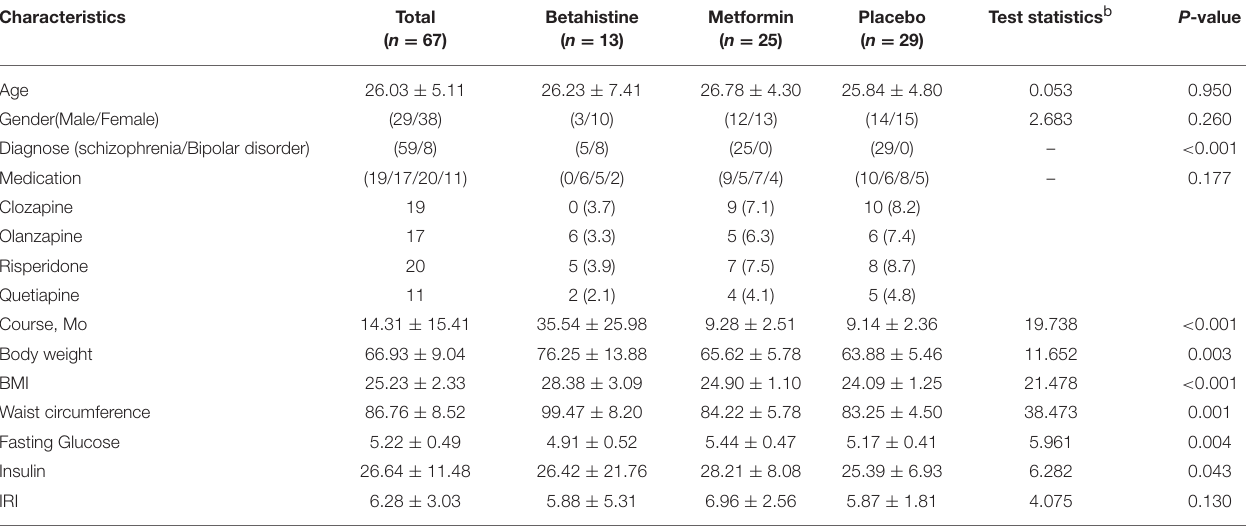
TABLE 1 | Demographic and clinical characteristics of 67 Participants across treatment groups at baseline a .